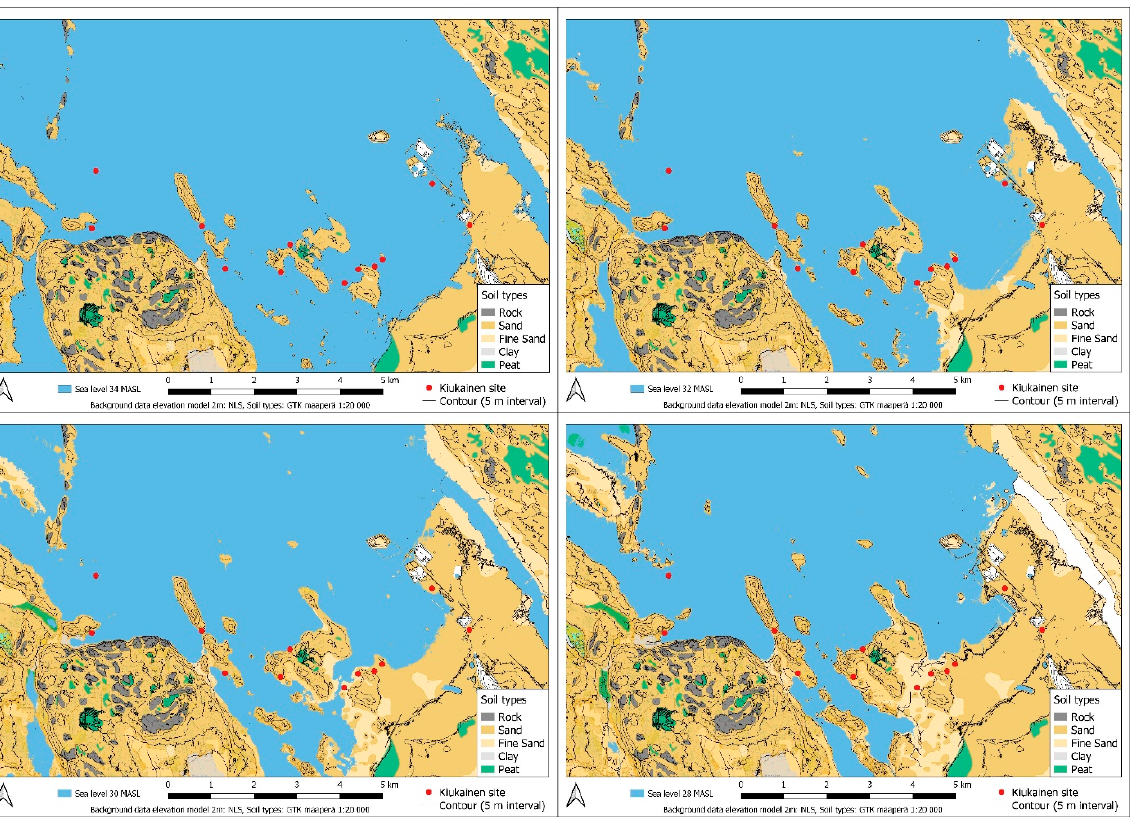
Figure 8. The locations of Kiukainen sites in the Harjavalta area with different landscape visualiza- tions. The Sea is visualized at 34 MASL (upper left), 32 MASL (upper right), 30 MASL (lower left), and 28 MASL (lower right). Soil types are visualized with different colours.